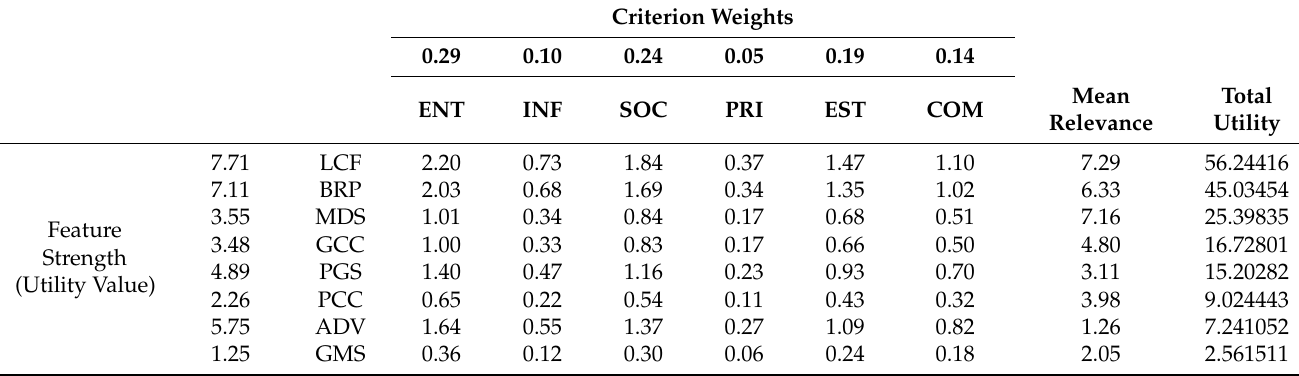
Table 6. Estimating the effect of social media features on mental health